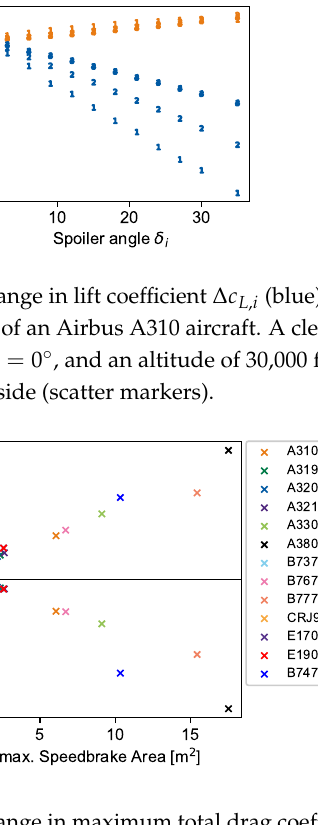
Figure 5. Change in maximum total drag coefficient ∆ c D ( top ) and maximum total lift coefficient ∆ c L ( bottom ) depending on maximum speed brake area A for thirteen different aircraft types assuming a clean flap configuration, a Mach number of 0.82, an angle of attack of α = 0 ◦ , and an altitude of 30,000 ft. Note the different scales on the